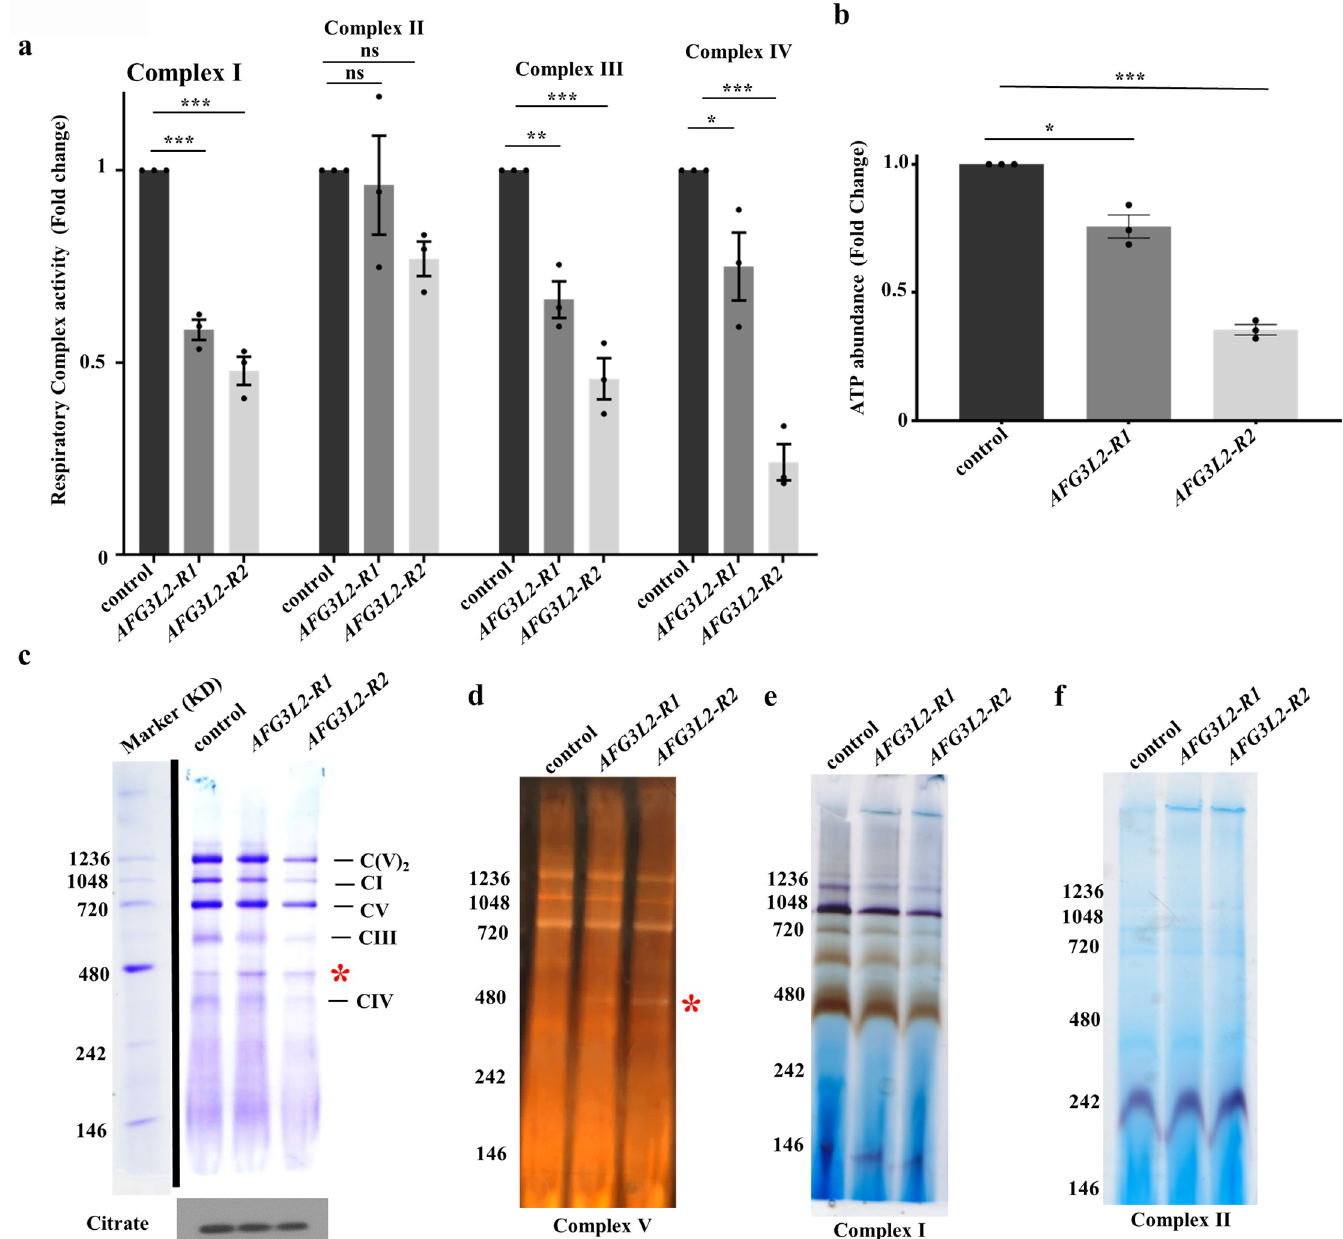
Fig 3. Afg3l2 deficiency confers diminished RC activity and abundance. a . RC activity in mitochondria isolated from control (UAS- LUCIFERASE RNAi/da-Gal4) and AFG3L2 -deficient (UAS- AFG3L2-R1 RNAi; da-Gal4 and UAS- AFG3L2-R2 RNAi/da-Gal4) pupae (N = 3 independent biological replicates, � p < 0.05, �� p < 0.005, ��� p < 0.0005 by one way ANOVA Tukey’s test for multiple comparison). b. ATP abundance in control (UAS- LUCIFERASE RNAi/da-Gal4) and AFG3L2 -deficient (UAS- AFG3L2-R1 RNAi; da-Gal4 and UAS- AFG3L2-R2 RNAi/da-Gal4) pupae (N = 3 independent groups of 5 pupae, � p < 0.05, ��� p < 0.0005 by one way ANOVA Tukey’s test for multiple comparison). c. BN-PAGE of mitochondrial protein extracts from control (UAS- LUCIFERASE RNAi/da-Gal4) and AFG3L2 -deficient (UAS- AFG3L2-R1 RNAi; da-Gal4 and UAS- AFG3L2-R2 RNAi/da-Gal4) pupae. Citrate synthase abundance was used as a loading control. Results of in-gel activity assays of mitochondrial complexes V (d) , I and IV (e) , and II (f) using the mitochondrial protein extracts from (c) . The red asterisk in (c) and (d) denotes the location of the sub- complex containing the F1 subunit of ATP synthase in AFG3L2 -deficient animals. For BN-PAGE and in-gel activity assays, images shown here are representative of two independent biological replicates.